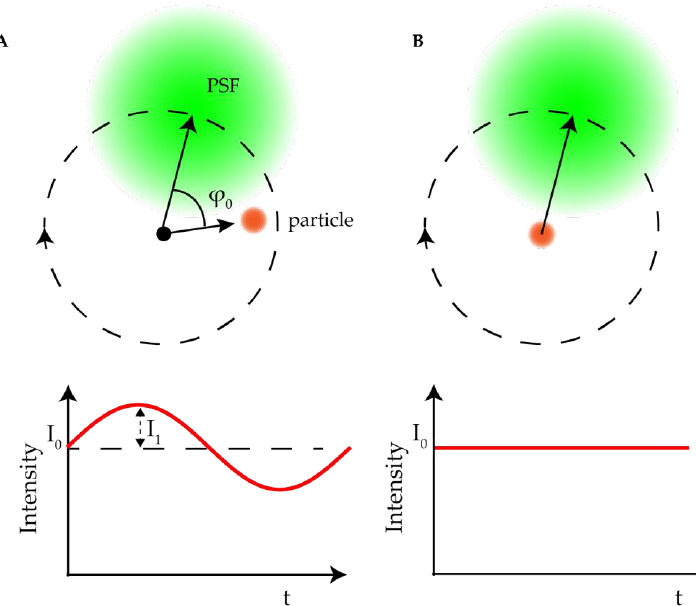
Figure 6. Concept of orbital tracking. The laser (green) is scanned laterally in a circular pattern around a particle (orange dot). ( a ) When a particle deviates from the center of the orbital scan, the fluorescence intensity ( 𝐼 0 , red curve in the low panel) of the particle is modulated at the same frequency as the laser scan. The phase ( ϕ 0 ) and intensity ( 𝐼 1 ) are extracted via FFT or lock-in amplifier and used to calculate the position of the particle within the orbit. The calculated position is used to relocate the particle so that the modulation of intensity is minimized. ( b ) When a particle is located in the center of the orbital scan, the fluorescence intensity of the particle remains stable with time.